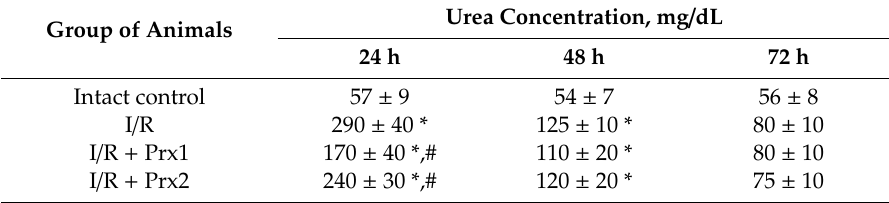
Table 4. Urea concentration in the blood of animals over three days after I / R injury of both kidneys. Urea Concentration, mg / dL Group of Animals 24 h 48 h